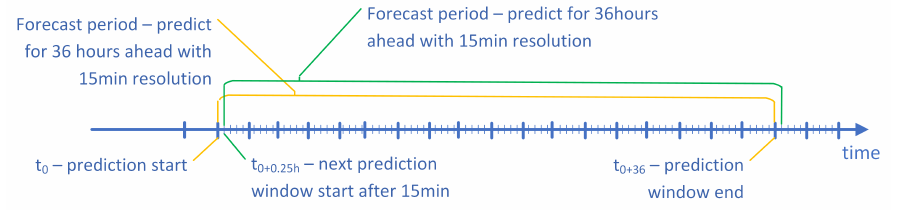
Figure 1. The scheme of the power generation system.